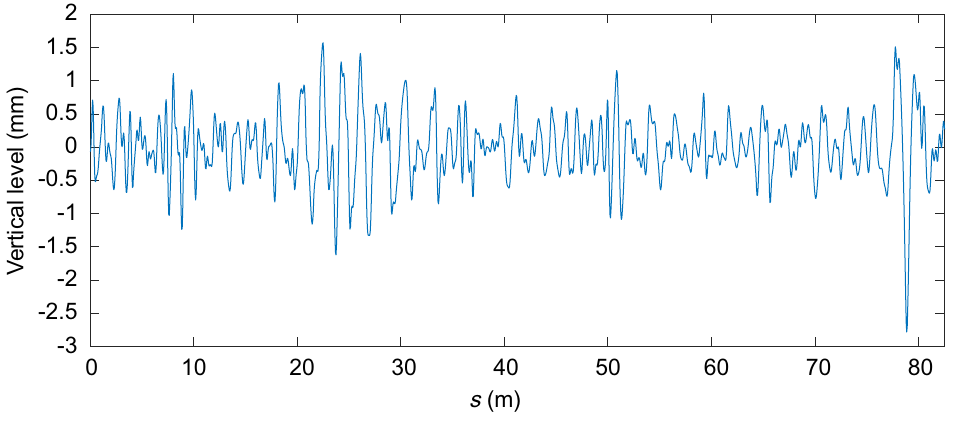
Figure 20. Filtered scaled track vertical profile